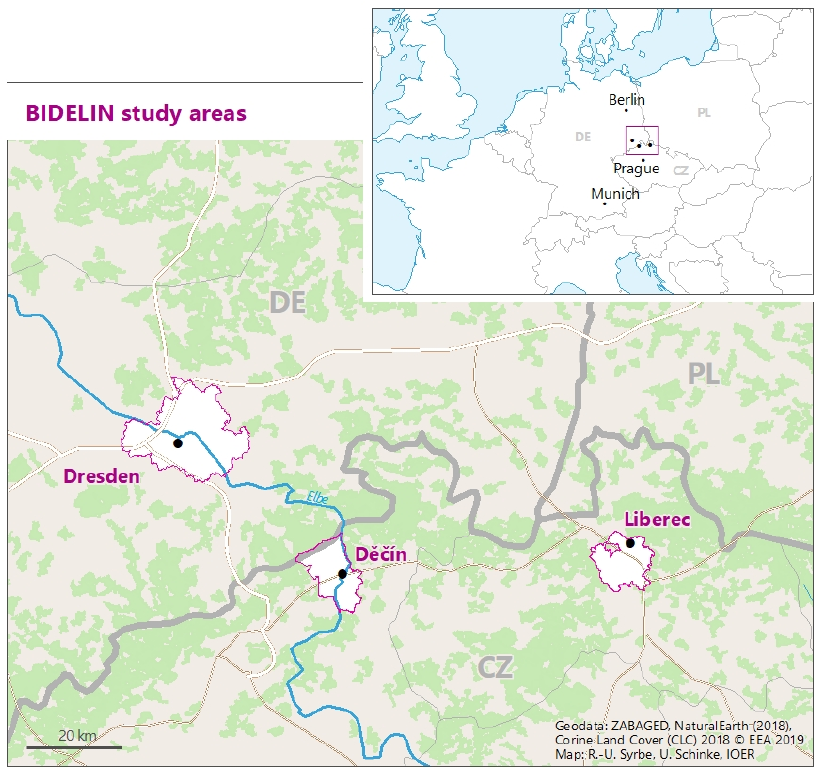
Figure 1. Locations of the surveyed areas in Germany and Czechia (source: authors’ elaboration).